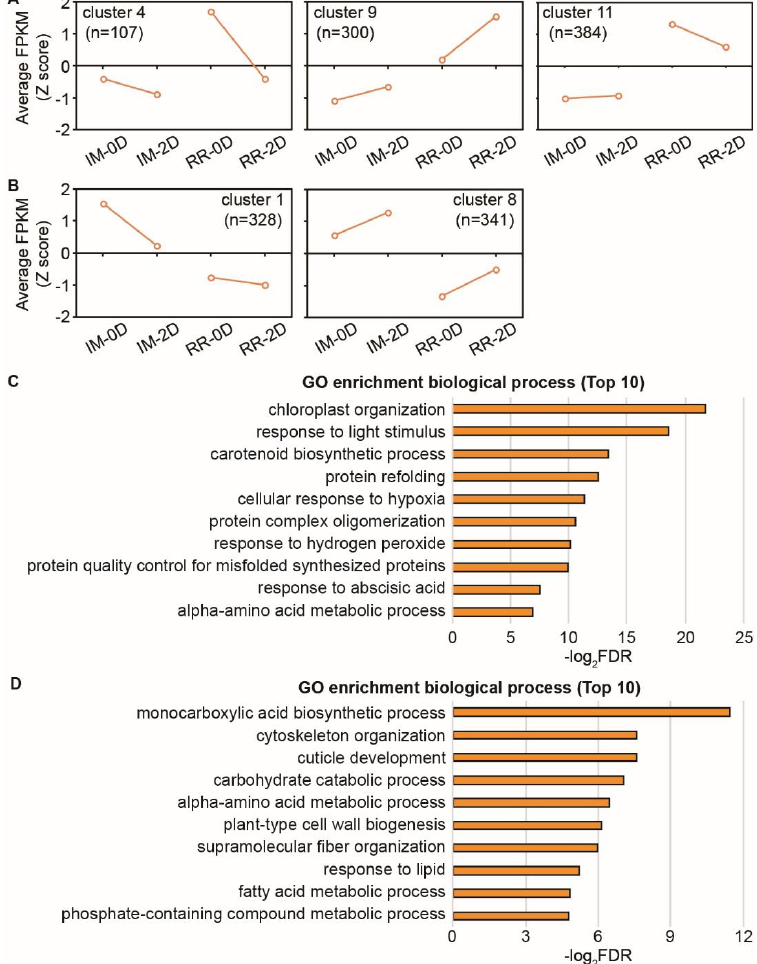
Figure 4. Co-expression analysis of the differentially expressed genes between immature and red ripening fruits. ( A ) The genes from clusters 4, 9, and 11 were more highly expressed in red ripening than in immature fruits. ( B ) The genes from clusters 1 and 8 had lower expression in red ripening than in immature fruits. ( C ) The top ten GO terms (biological processes) were enriched by genes from clusters 4, 9, and 11. ( D ) The top ten GO terms (biological processes) were enriched by genes of clusters 1 and 8. Group 1 genes contained 42 transcription factors, namely, 6 AP2/ERF (Solyc03g044300.3,